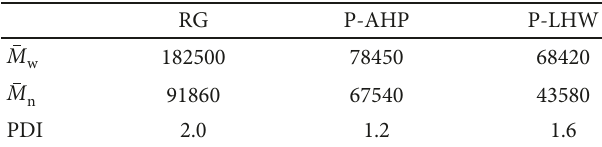
Table 1: Molecular weights (weight average, M average, M n ) and polydispersities (PDI) of the polysaccharide